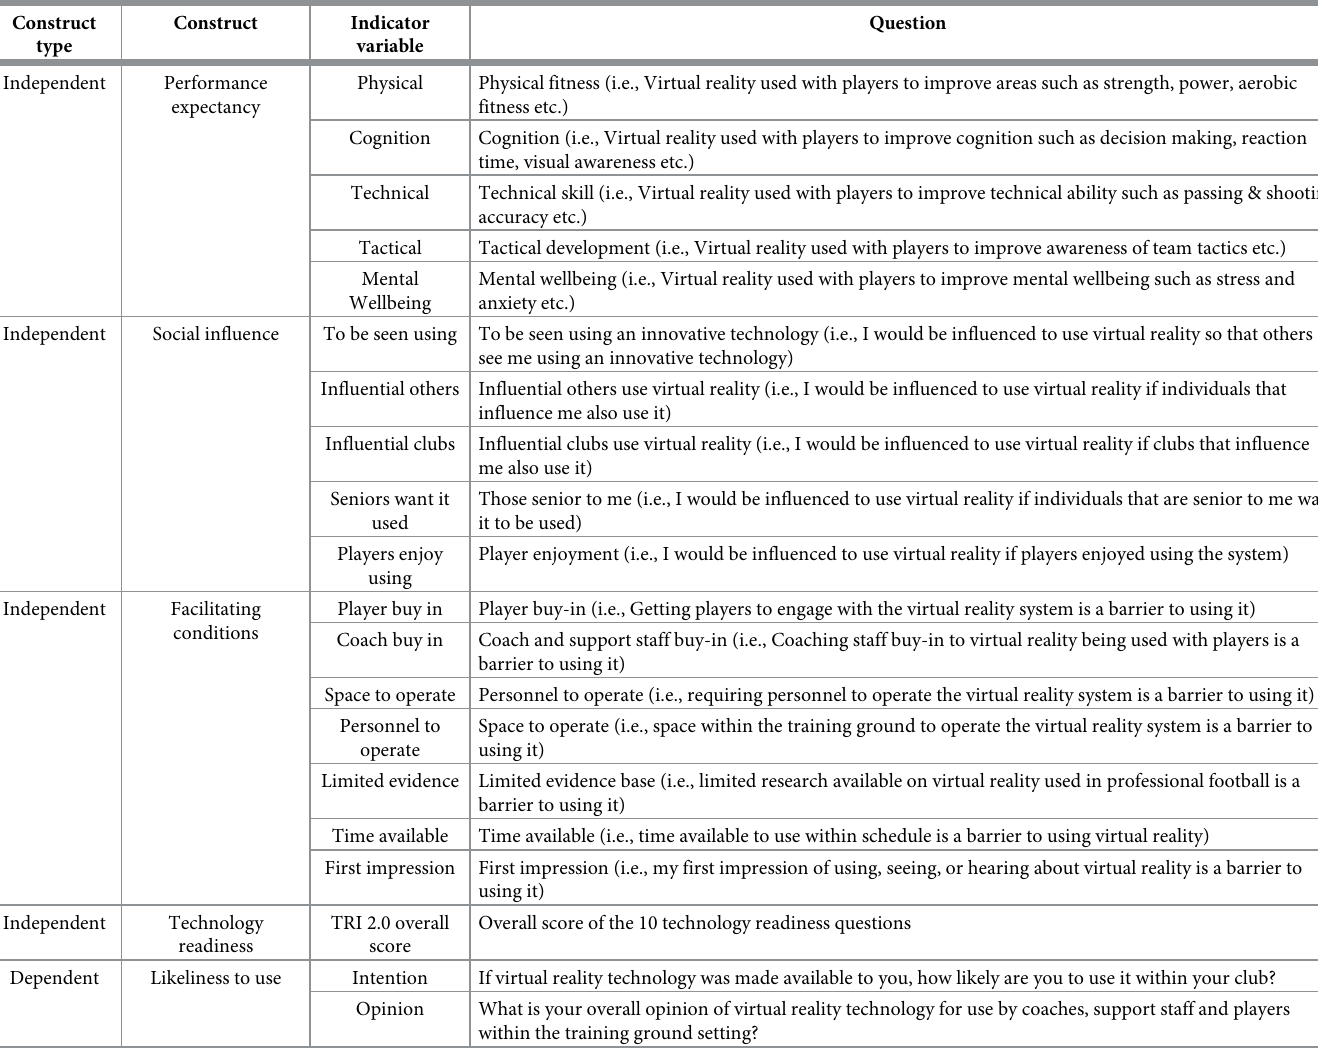
Table 1. Specification of the PLS-SEM constructs, indicator variables and survey